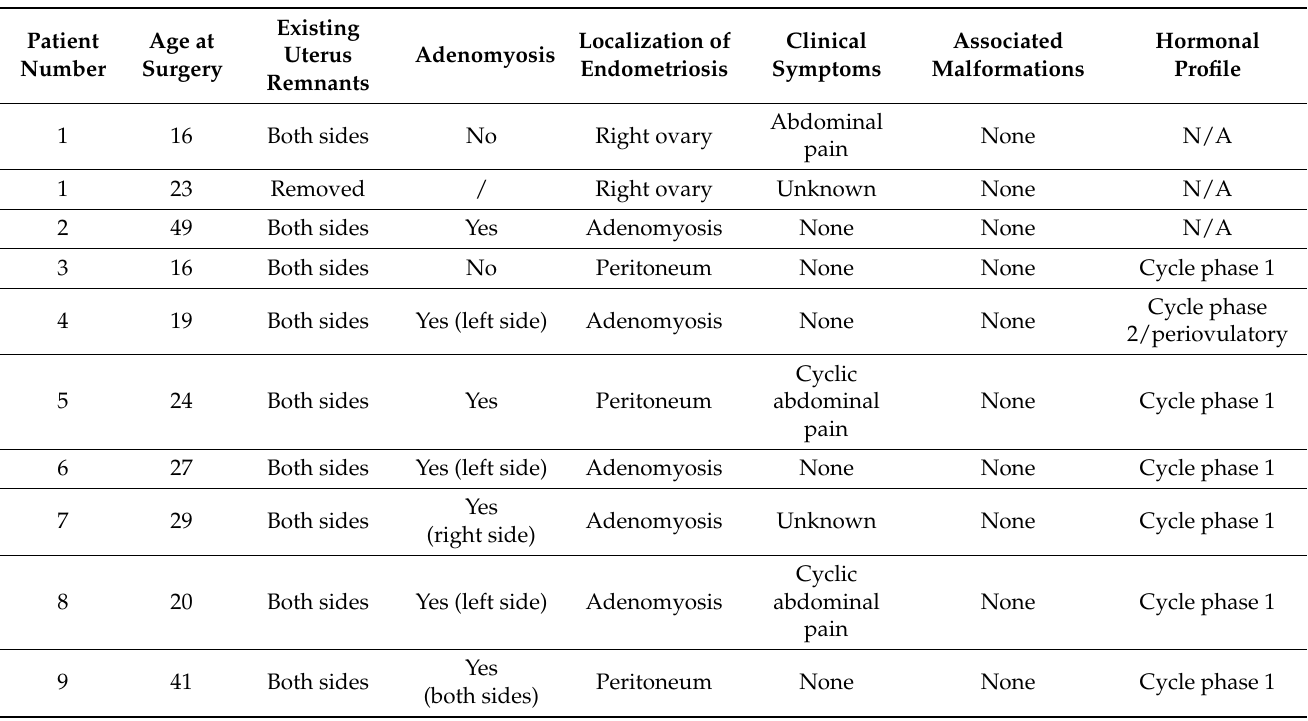
Table 1. Clinical